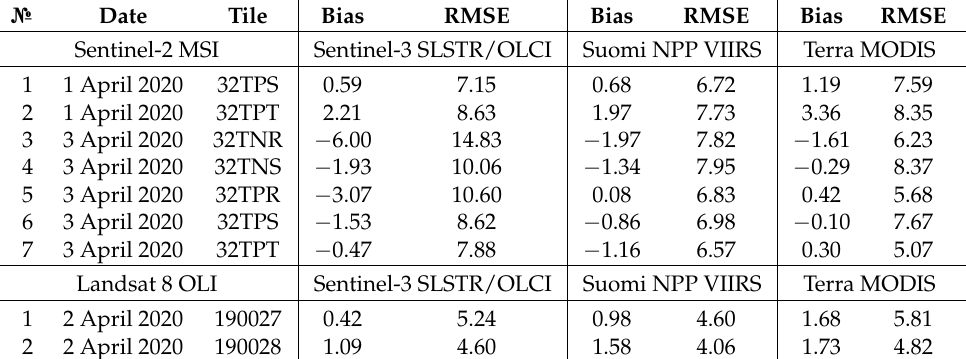
Table 5. Comparison of SCF maps using the LAMSU method for different medium-resolution sensors against individual SCF maps from Sentinel-2 MSI data using the LAMSU method. The two columns for each sensor show the multi-sensor SCF bias (row minus column) and multi-sensor RMSE in percent SCF, respectively. The high-resolution granules are identified by their date and UTM tile for Sentinel-2 MSI and path/row for Landsat 8 OLI. More details can be found in Table